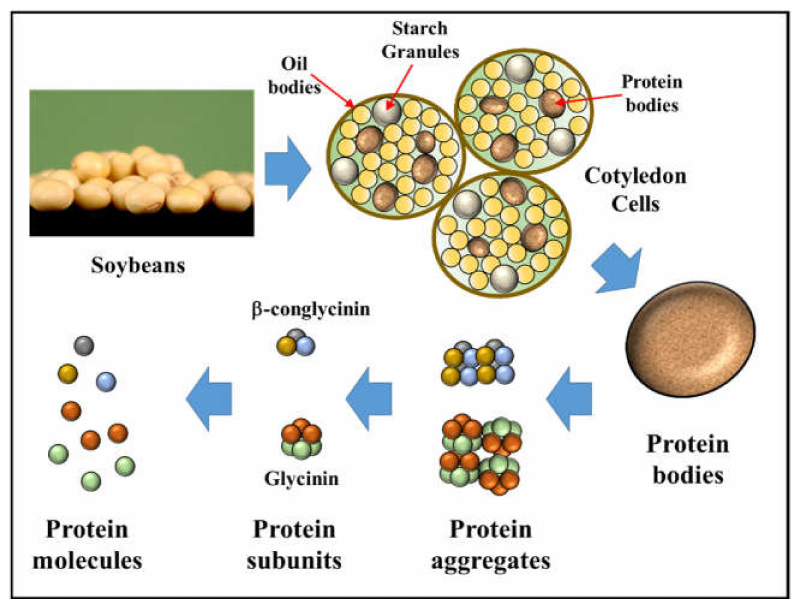
Figure 14. Plant proteins are isolated from plant materials, such as soybeans, using various separation and purification processes. The native and aggregation state of the proteins obtained depends on the isolation methods used. The dimensions of the different entities in the schematic diagram are not drawn to scale. Image of soybeans by Amy Wilson, CSIRO (http://www.scienceimage.csiro.au/ image/3273 (accessed on 9 February 2022)) (Crea-tive Commons